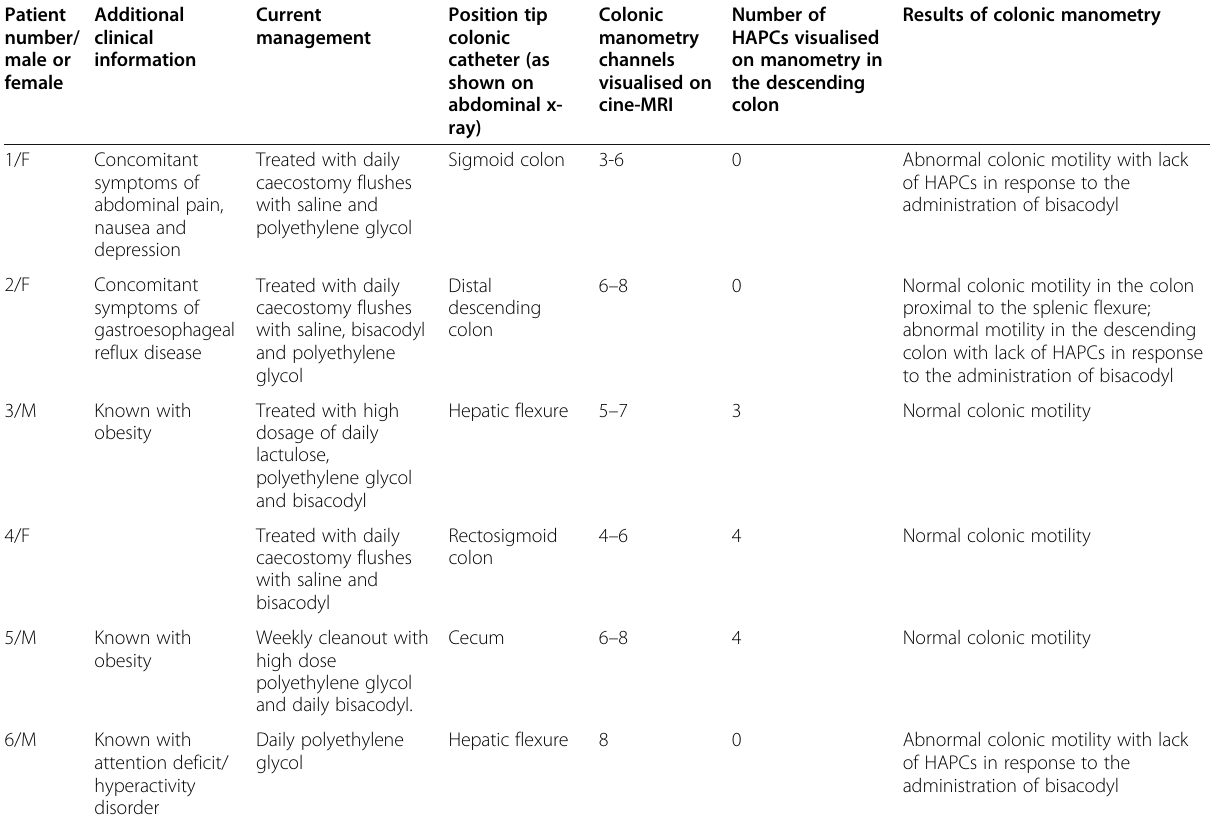
Table 1 Colonic manometry data Patient